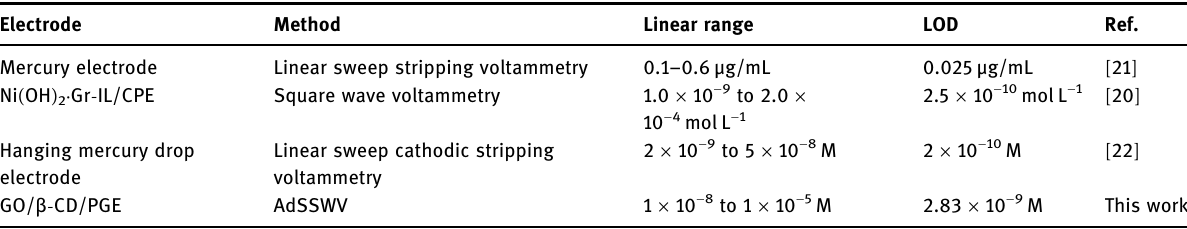
Table 1: Comparison of electrochemical studies about sulpiride